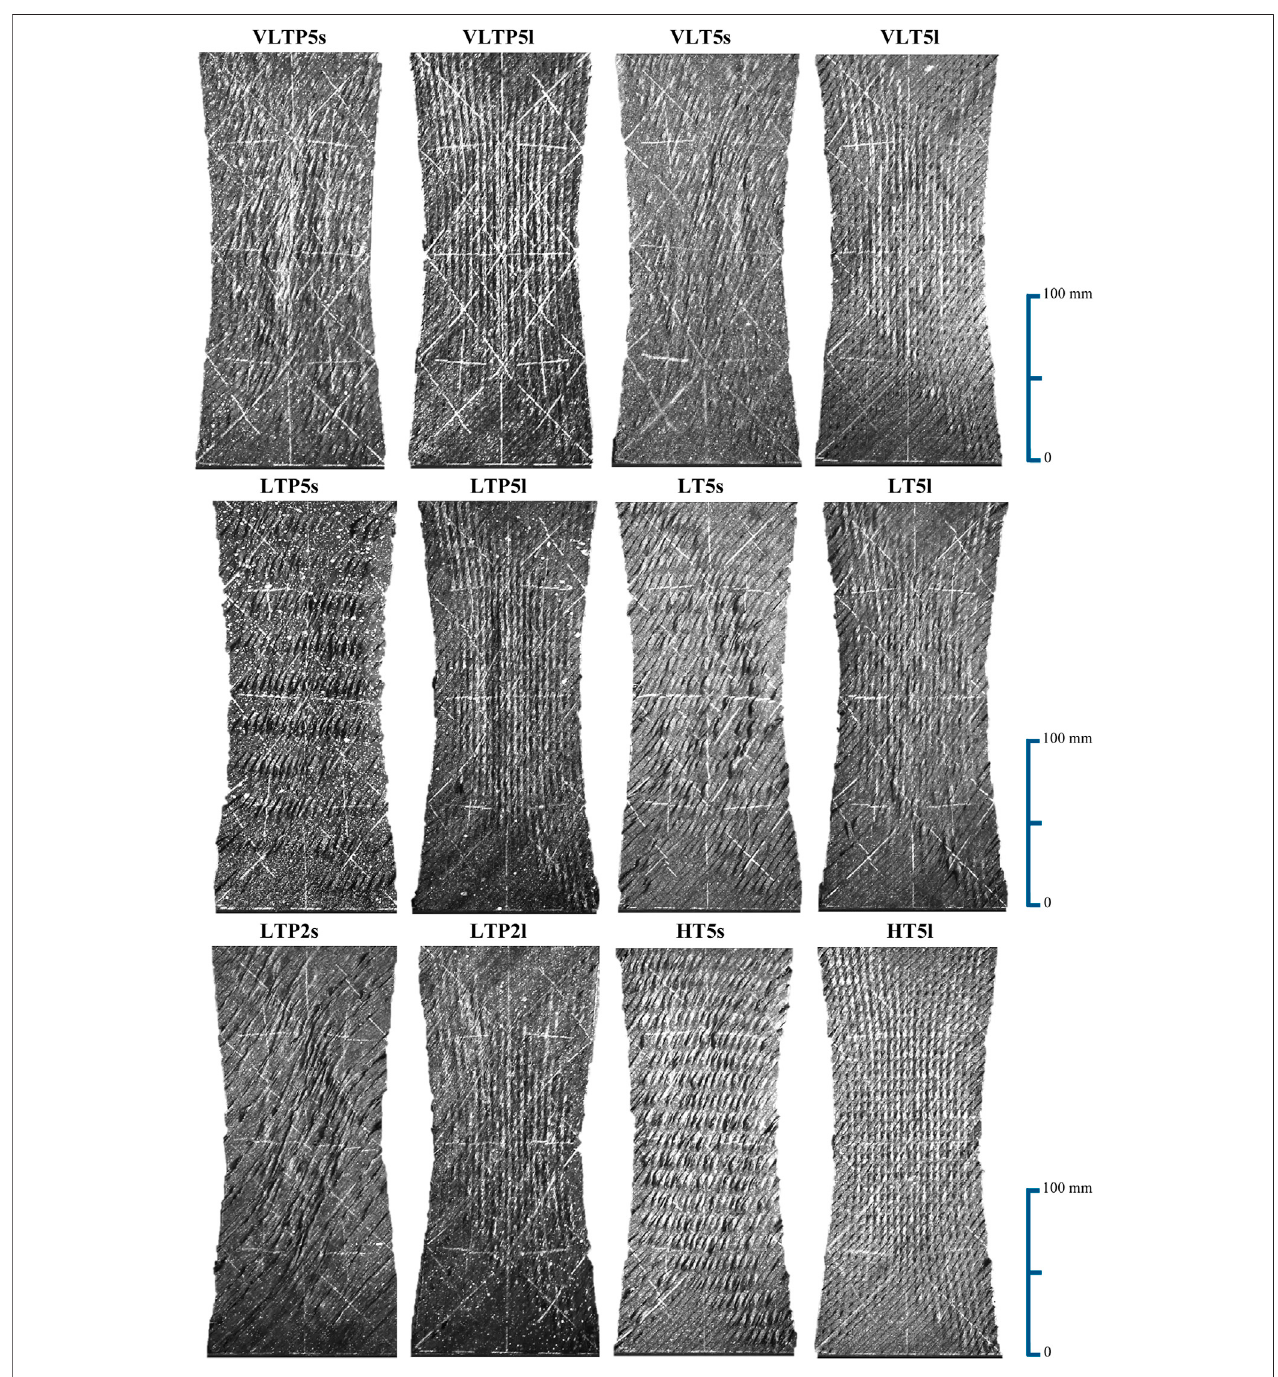
FIGURE 9 | Bias extension appearance for six NCF formats, stitch and loop side